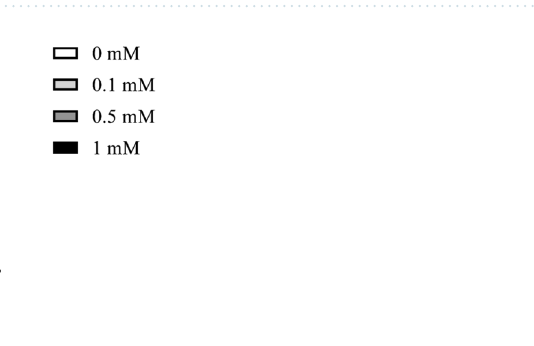
Figure 6. Chlorophyll and carotenoid pigment levels of seedlings treated with Phe, effusol and juncusol at different concentrations compared to MeOH. Data are presented as the mean ± SE (n = 6). Different letters indicate significant differences between the values of the treatments (P < 0.05) analysed by Tukey’s post-hoc test.